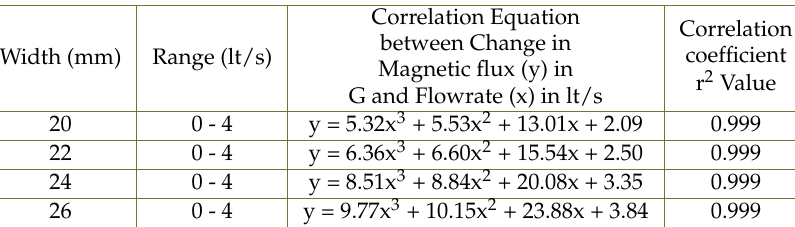
Table 2. Correlation parameters for target plate with varying widths